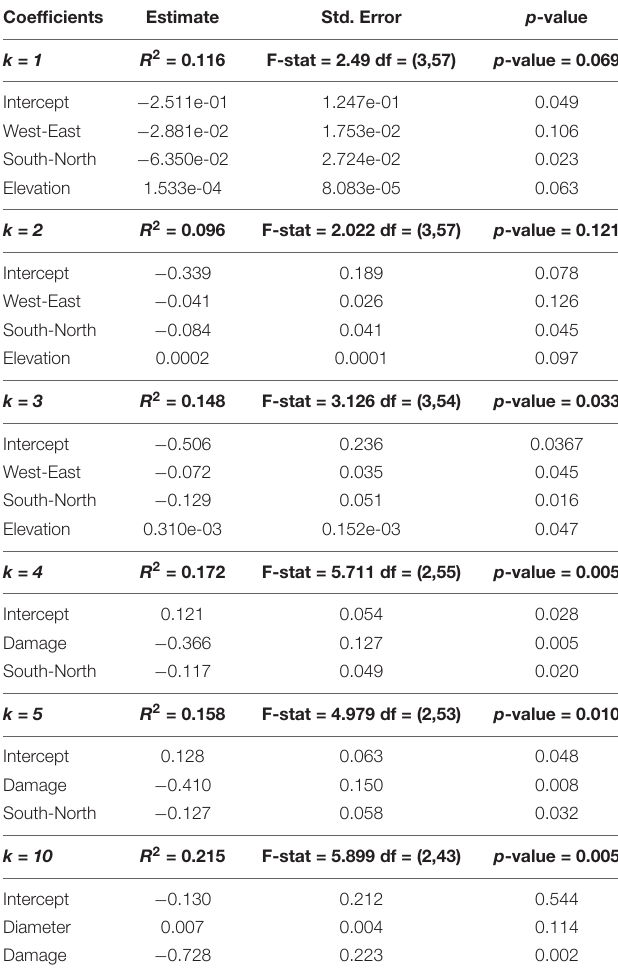
TABLE 5 | Results of model selection after the two-step model has been